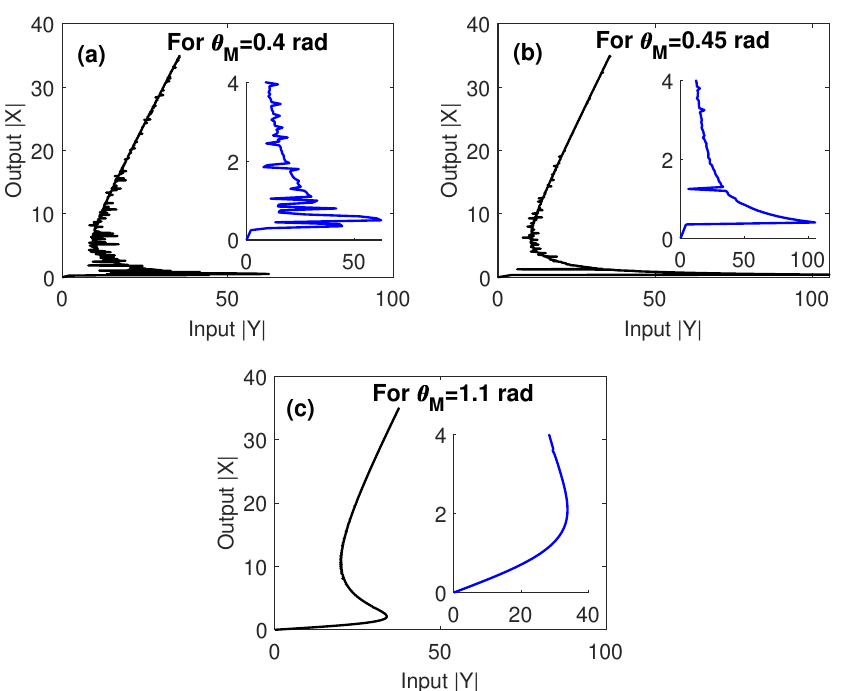
Figure 3. The output versus the input for different values of the inclination angle of MNP with respect to QD, under EIT conditions; R M = 15 nm, R = 5 nm, θ G = 1 rad and C = 121.36, and the mobility of GND was µ = 10 4 cm 2